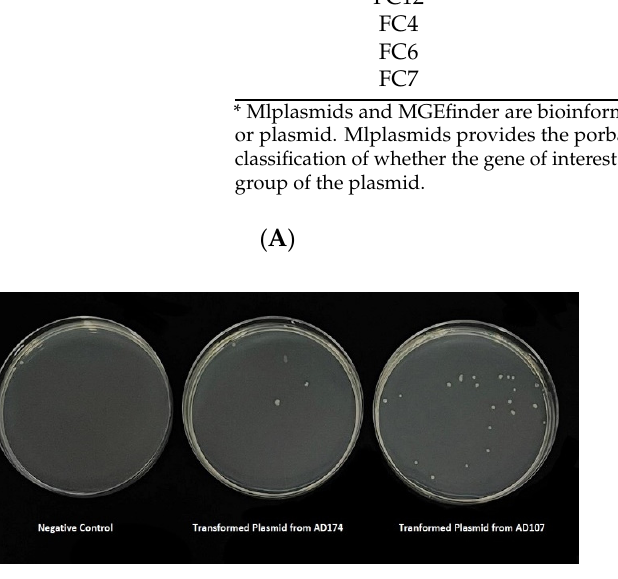
Figure 2. ( A ) Representative image of the One Shot TM OmniMAXTM 2 T1R E. coli growth in Muller–Hinton media supplemented with 4 µ g/mL of colistin following heat-shock transformation. The negative control underwent the heat-shock method without adding plasmid. ( B ) Agarose